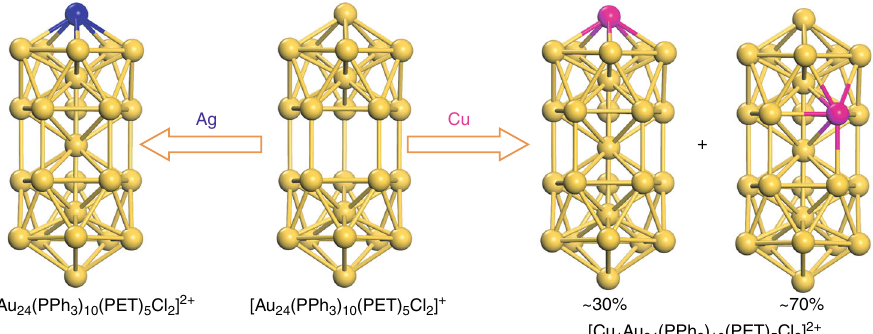
Fig. 3 Shuttling one Ag or Cu atom into the 24-atom hollow gold nanoparticle: pathways of single Ag/Cu entering the hollow Au 24 nanoparticle. Note, Ag 1 Au 24 and Cu 1 Au 24 are presented using X-ray cryptographic data of this work, and Au 24 structure is adopted from ref. 36 . Color codes: Au, yellow; Ag, blue; Cu, magenta. Other non-metal atoms are not shown for